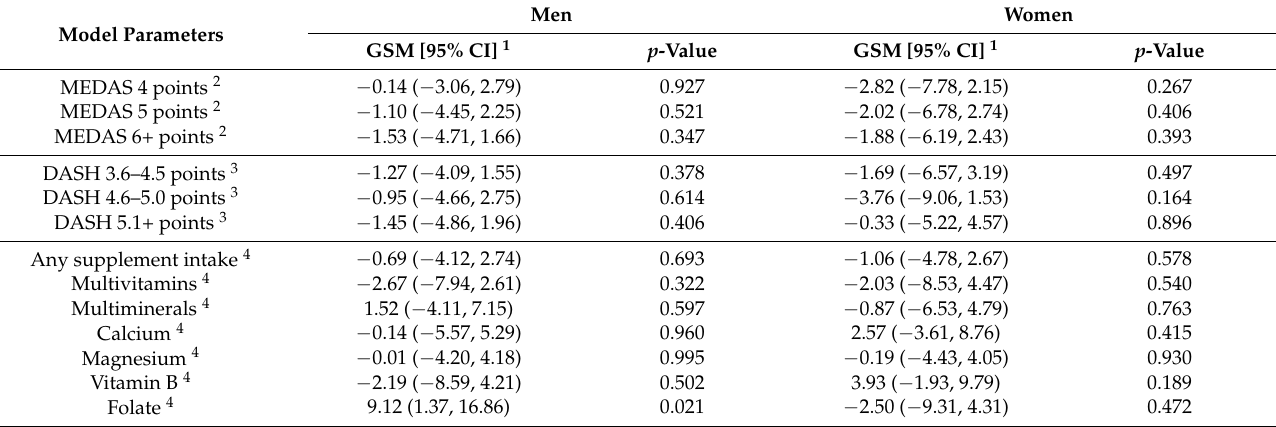
Table 2. Linear regression models for Outcome GSM (0 to 255) in men and